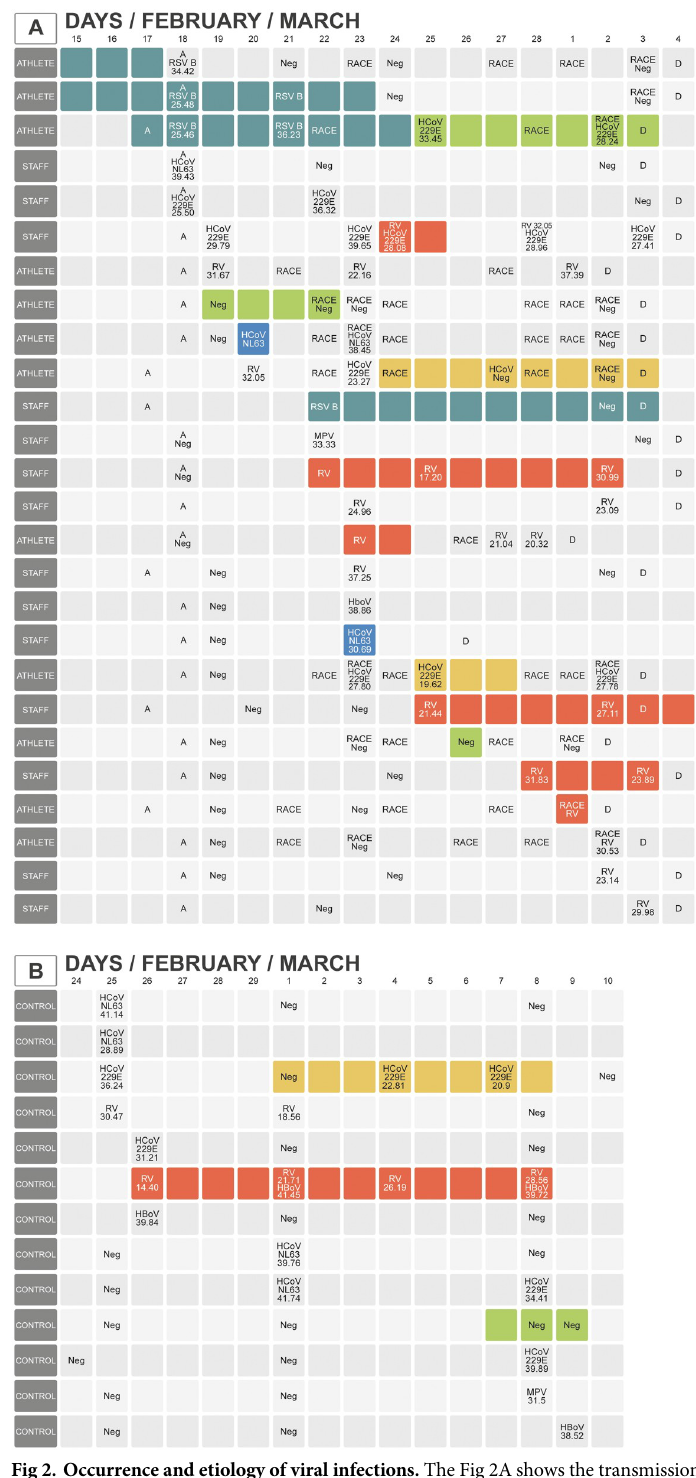
PLOS ONE | https://doi.org/10.1371/journal.pone.0250907 May 4, 2021 6 /